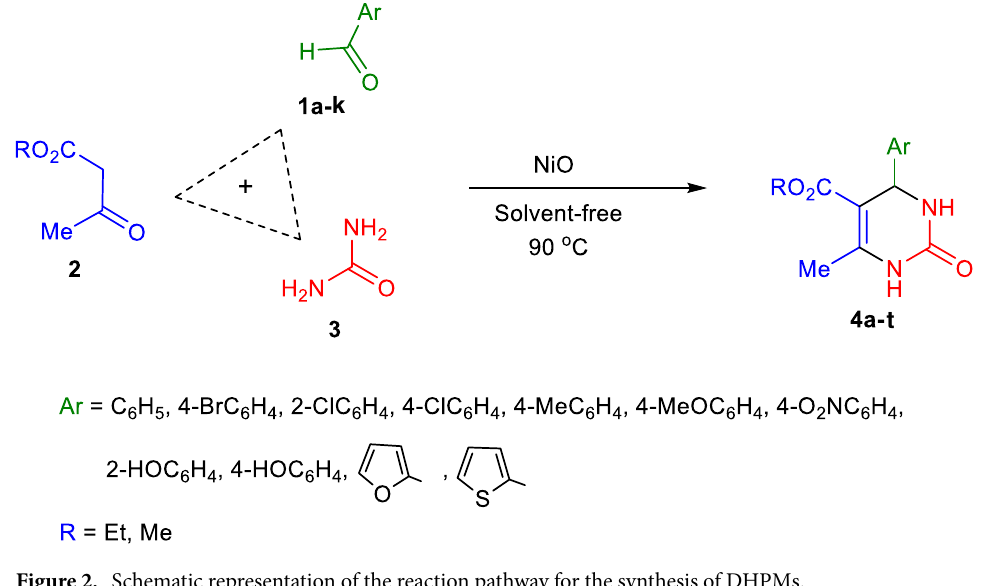
Figure 2. Schematic representation of the reaction pathway for the synthesis of